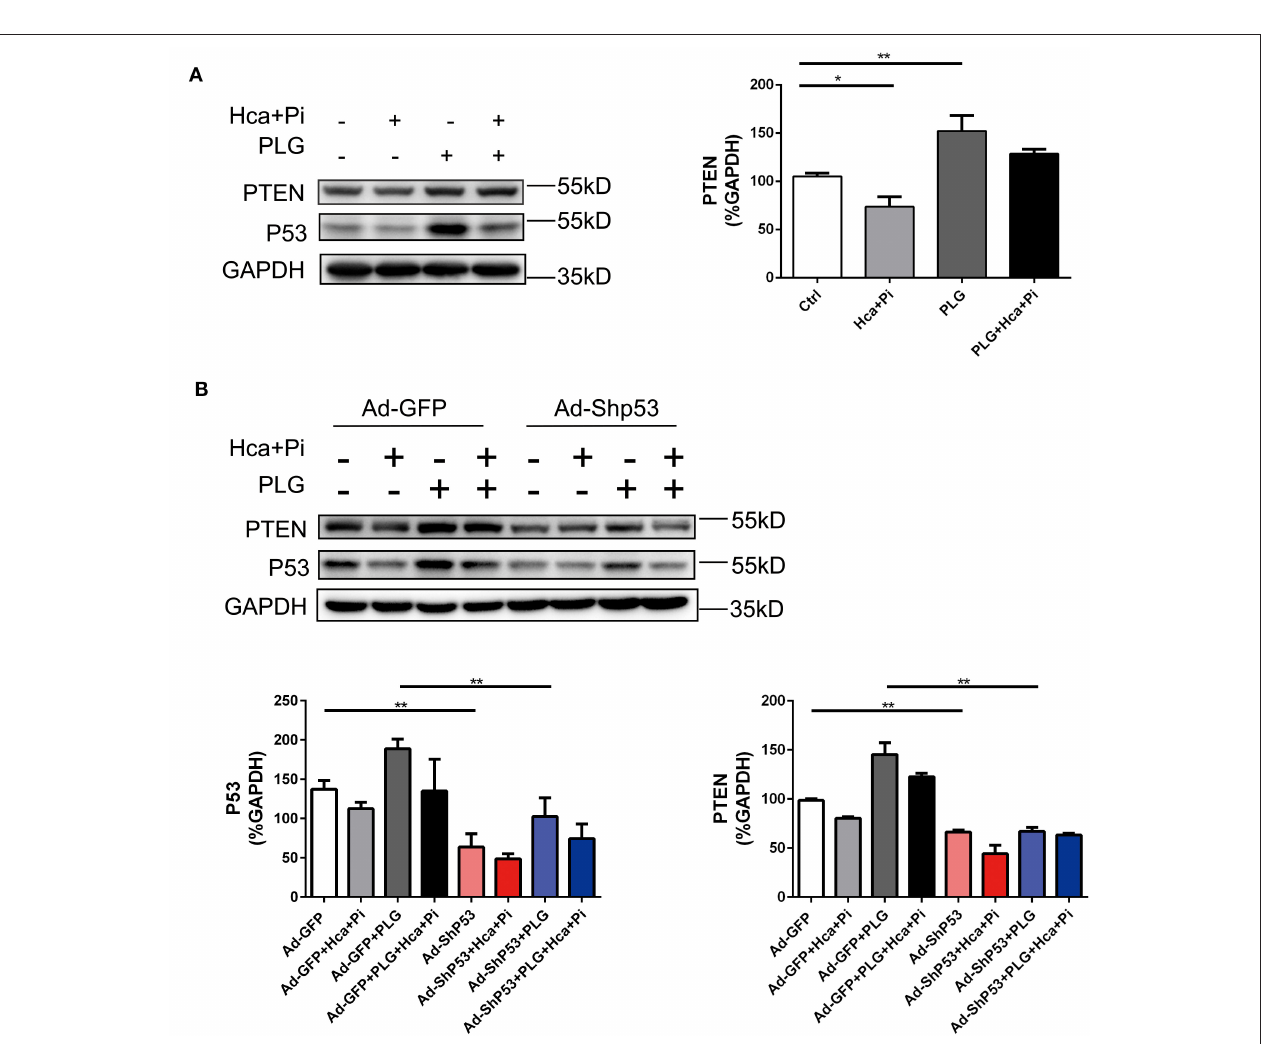
FIGURE 5 | of triplicate sets and are representative of three independent experiments. (B) RVSMCs were treated with PLG (2.5 µ M) and high calcium/phosphate. After knocking down P53 with P53 ShRNA, ALP activity was measured with the LabAssay TM ALP Kit. (C) Calcium content was measured with the QuantiChrom TM Calcium Assay Kit. (D) Alizarin red staining was used to evaluate cellular calcium deposition. (E) The mRNA levels of Runx2, OPN, Bmp2, and P53 in RVSMCs were measured by qRT-PCR after knocking down P53 ( n = 6 for each group). (F) The protein levels of Runx2, OPN, Bmp2, SM22 α , and P53 were measured by western blotting. The relative protein levels were normalized to the level of GAPDH. The data are shown as the mean ± standard error of triplicate sets and are representative of three independent experiments (* P < 0.05, ** P < 0.01, and *** P < 0.001 indicate significant differences between the indicated columns).